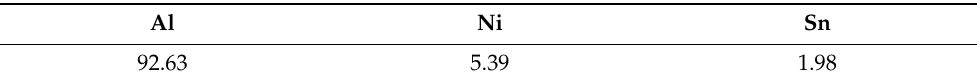
Table 1. Chemical compositions of Al-5.4Ni-2Sn alloy (wt.%).